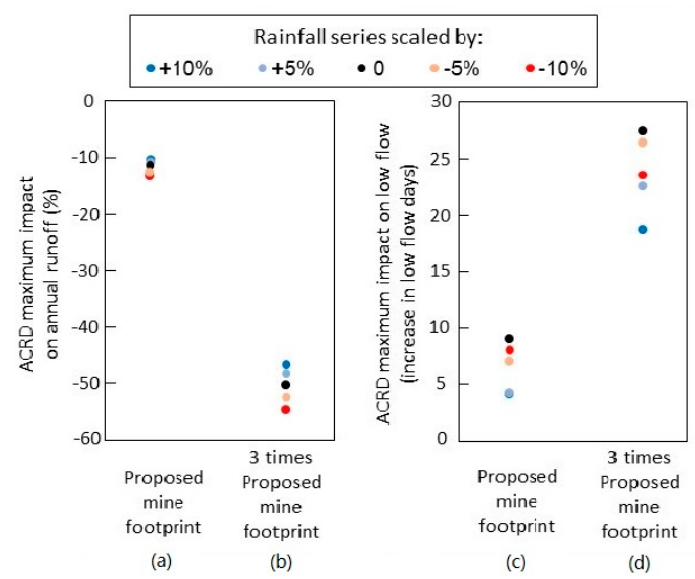
Figure 8. ACRD maximum impact at Node 14 for annual runoff for ( a ) proposed mine footprint and ( b ) three times larger mine footprint, and ACRD maximum impact on low flow days for ( c ) proposed mine footprint and ( d ) three times larger mine footprint.